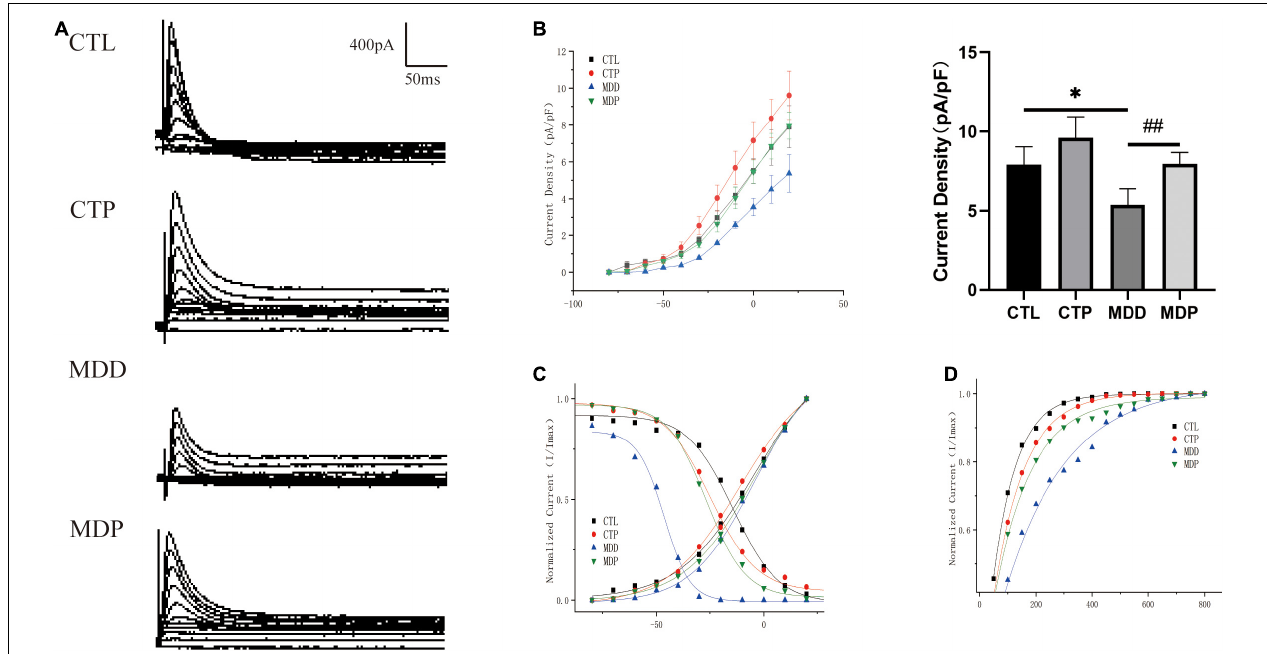
FIGURE 6 | Electrophysiological characteristics of I to . (A) Typical I to current traces. (B) The voltage-dependent current density (the I-V curve) and maximum current density of I to . (C) The voltage-dependent activation curve and the steady-state inactivation curve fitted to the Boltzmann distribution. (D) The recovery curve fitted to the monoexponential function. n = 6 per group. * p < 0.05 vs. CTL; ## p < 0.01 vs.